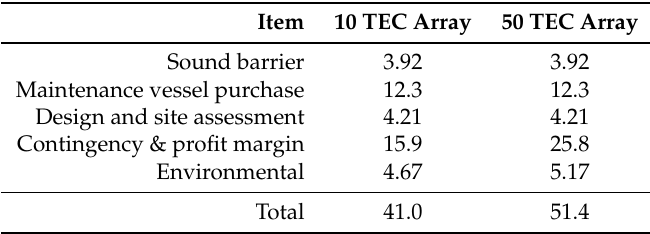
Table 4. RM1 CAPEX contributions from externalities in 1 the rate of 1 $ = 0.85 (cid:100) ).